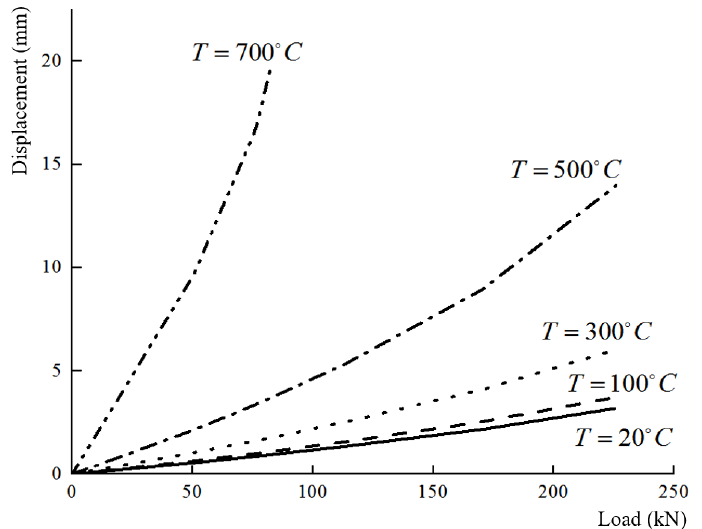
Figure 9. Comparison of load–displacement relationship of axially compressive concrete column at different temperatures.